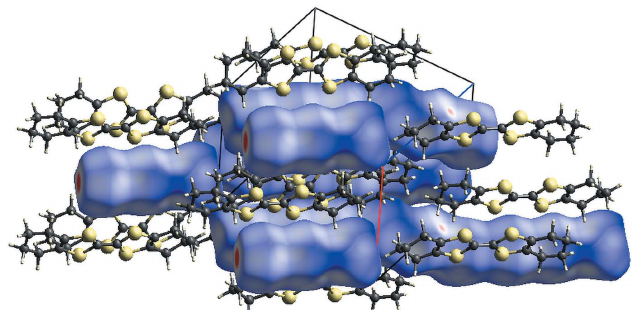
Figure 4 Section of the crystal structure of the title compound, (cid:2) -(OMTTF)I 3 . The Hirshfeld surface representation ( d norm ) is drawn for the I atoms, while the (OMTTF (cid:4) + ) entities are drawn using a ‘ball-and-stick’ model for clarity. The surface regions with strongest intermolecular interactions are shown in magenta, the (I 3 (cid:3) ) (cid:2)(cid:2)(cid:2) (I 3 (cid:3) ) interactions for example. The surface regions with weak interactions, e.g. the H (cid:2)(cid:2)(cid:2) I contacts, are pale magenta in colour. The strongest and the frequently observed intermolecular interactions (in %) are not necessarily are the same. The a axis is drawn in red and the c axis is drawn in blue.